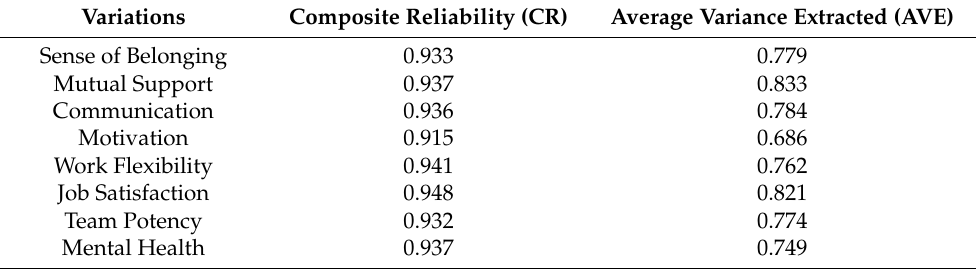
Table 3. Convergence feasibility validation.